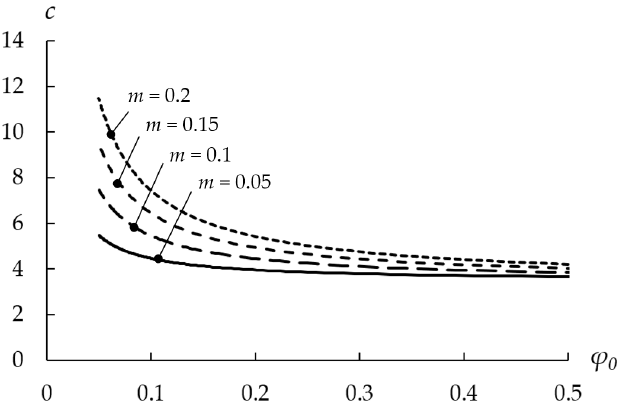
Figure 3. Variation of c with the die semi-angle at several friction factors.